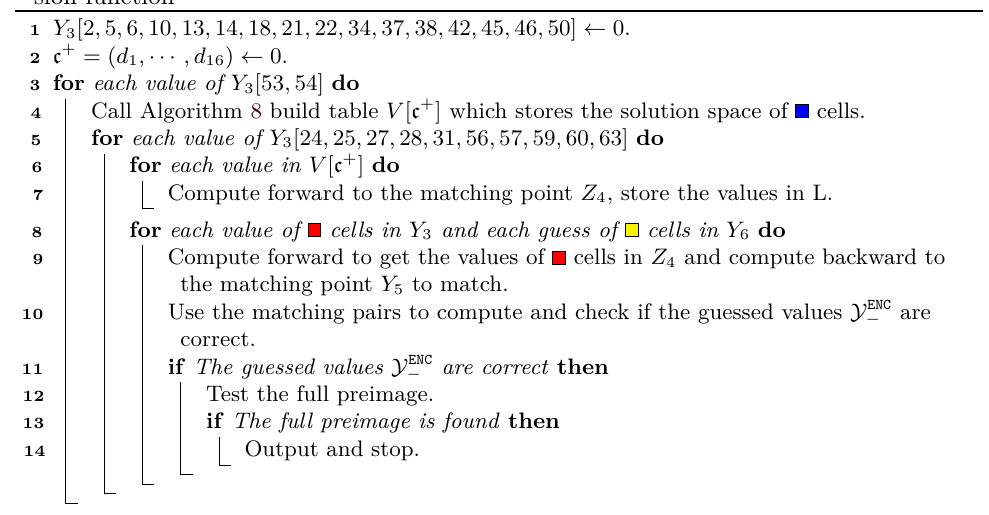
Algorithm 9: The MITM preimage attack on 6.5-round Streebog-256 compres- sion